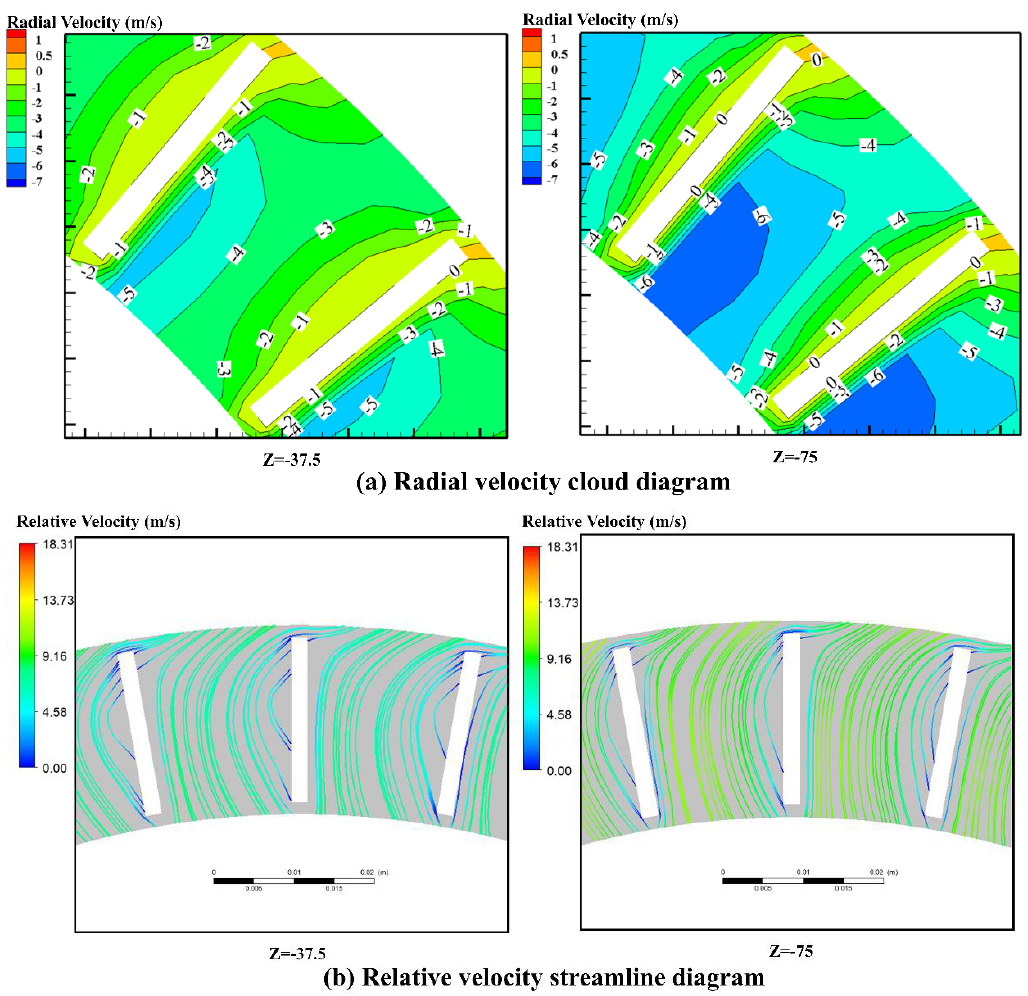
Figure 10. The cloud diagram for the radial velocity distribution and relative velocity streamline corresponding to the straight blade.